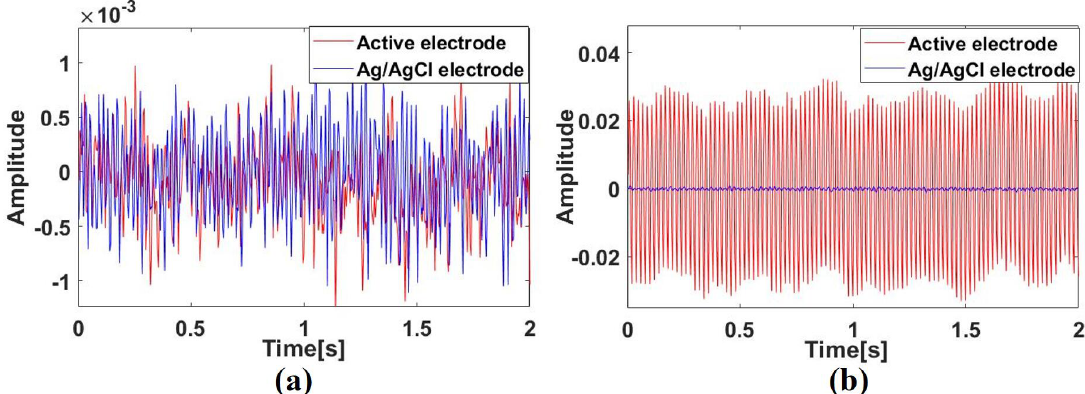
Figure 10. Output noise of system under short connection of electrodes: ( a ) electrodes of the active electrode system short connect directly, ( b ) electrodes of the active electrode system short connect through clothes (a simple cotton underwear about 1 mm in